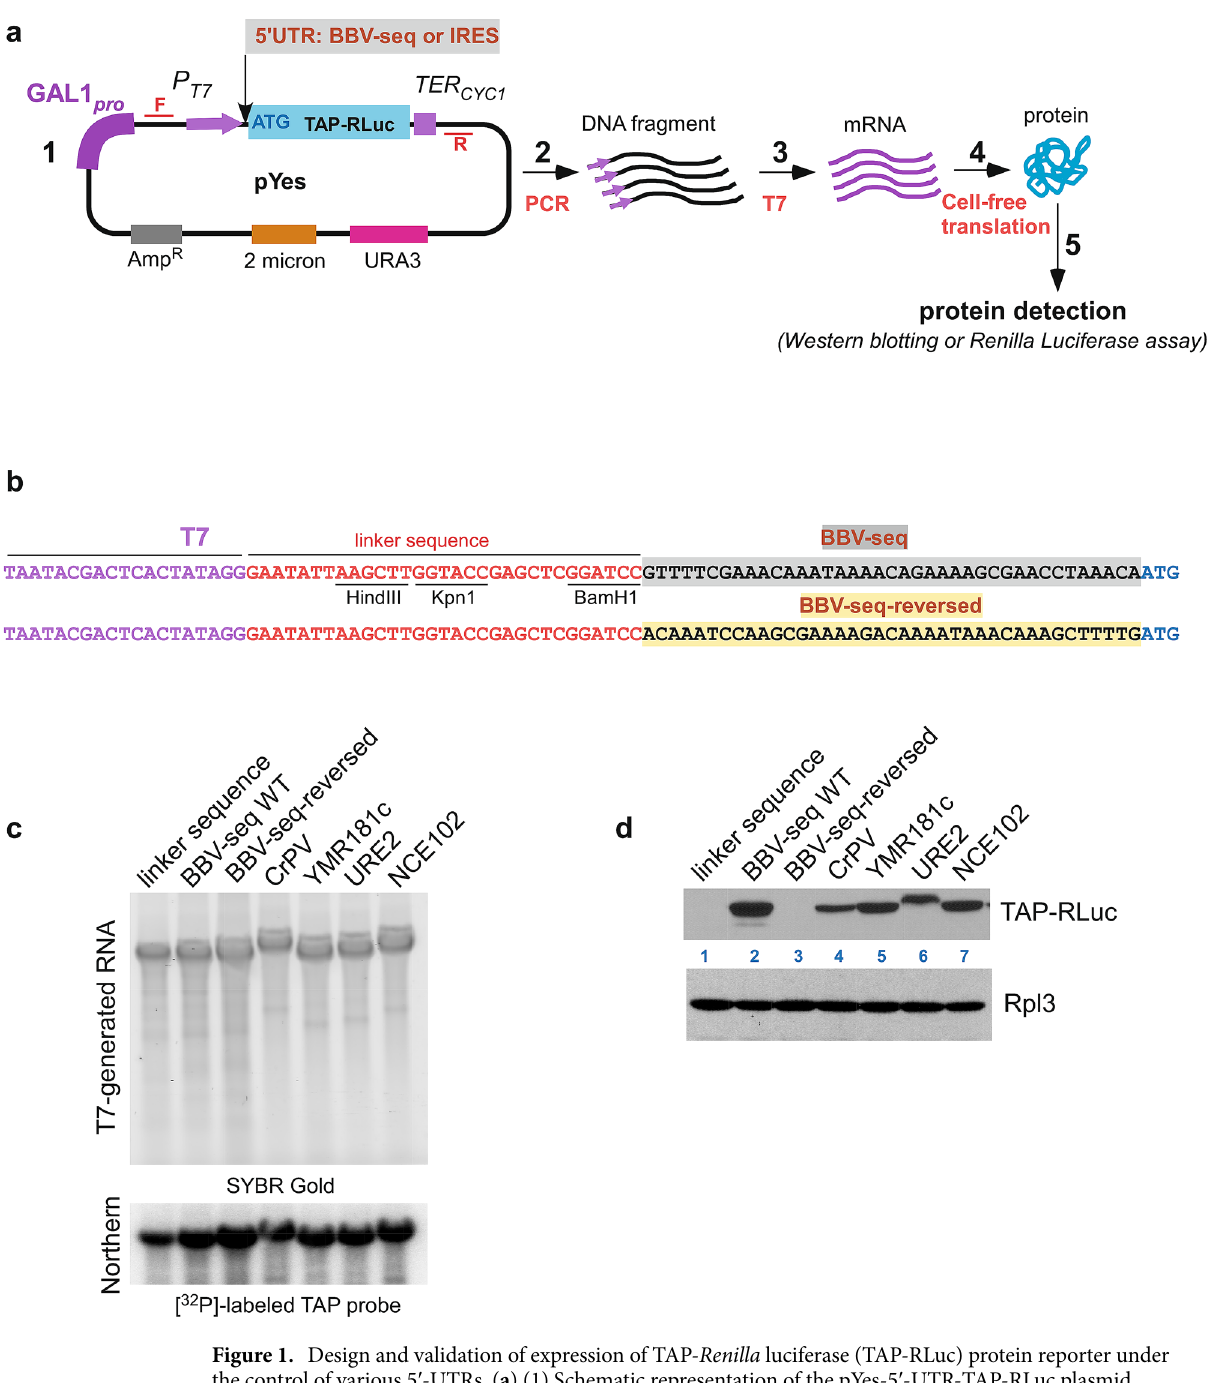
Figure 1. Design and validation of expression of TAP- Renilla luciferase (TAP-RLuc) protein reporter under the control of various 5 ʹ -UTRs. ( a ) (1) Schematic representation of the pYes-5 ′ -UTR-TAP-RLuc plasmid. A T7 promoter ( P T7 ) and a CYC1 terminator ( TER CYC1 ) flank the TAP-RLuc coding sequence. Insertion of a 5 ʹ -UTR upstream of the TAP-RLuc coding sequence is shown. Forward (F) and reverse (R) primers that allow amplification of 5 ʹ -UTR-TAP-RLuc are shown in red. The pYes-5 ʹ -UTR-TAP-RLuc construct also carries a URA3 selectable marker, 2µ DNA replication origin, and ampicillin resistance gene (2–5). Workflow of the reporter protein synthesis in the cell-free translation system. Amplified 5 ʹ -UTR-TAP-RLuc (2) was used in the T7 polymerase reaction to generate mRNA (3); this mRNA was added to the cell-free translation reaction (4), resulting in protein synthesis and detection (5). ( b ) Sequence of nucleotides located upstream of ATG in the pYes-derived construct from ( a -1). From left to right: T7 promoter sequence (purple) and linker (red) sequences are followed by various BBV-seq sequences (highlighted in gray) or BBV-seq-reverse sequence (highlighted in yellow). ( c ) mRNA generated in ( a -3) was separated on denaturing 1.2% agarose gel and stained with SYBR Gold (top). RNA was transferred onto nylon membranes and subjected to northern hybridization using a [ 32 P]-labeled TAP-specific probe (bottom). ( d ) Translationally competent yeast lysates were charged with mRNA from ( c ) and the reaction products were analyzed by western blotting using anti-TAP antibodies (top) and anti-Rpl3 control antibodies